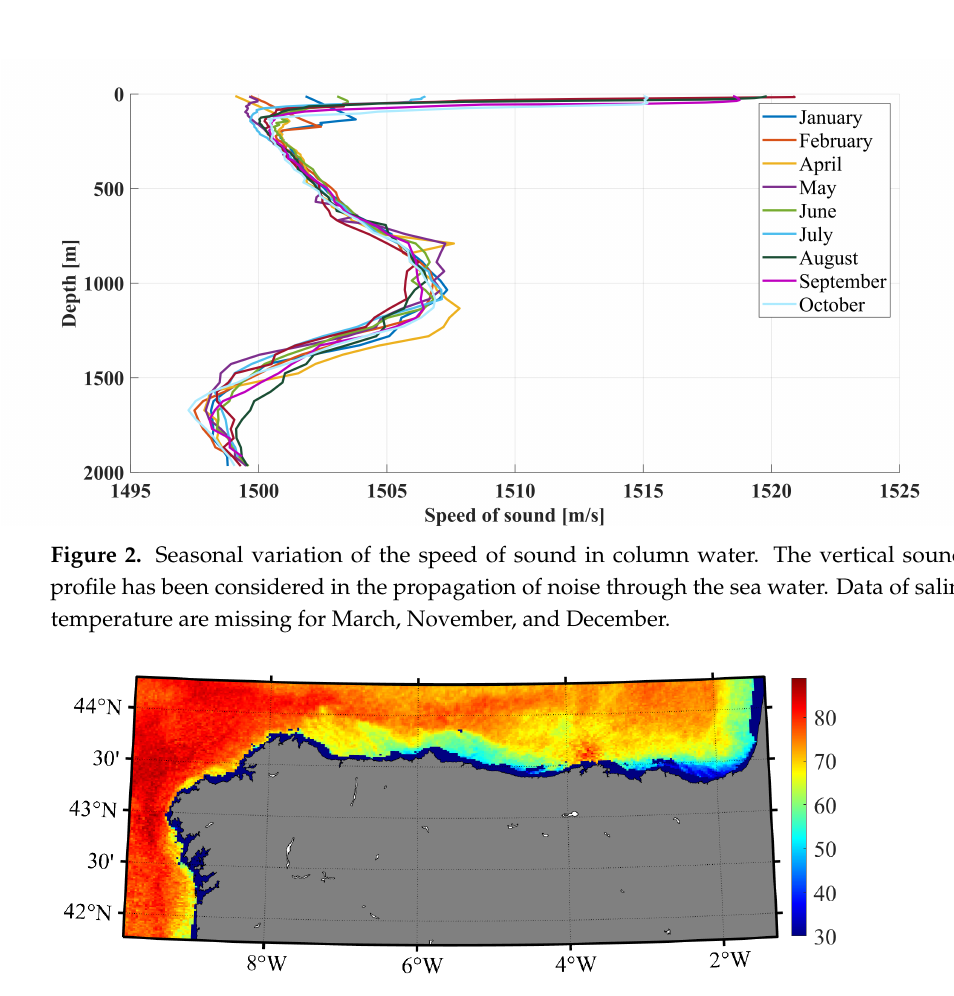
Figure 3. Shipping noise map calculated at 1 kHz frequency band for 2019. The color bar represents the Sound Pressure Level (SPL) dB ref 1 µ